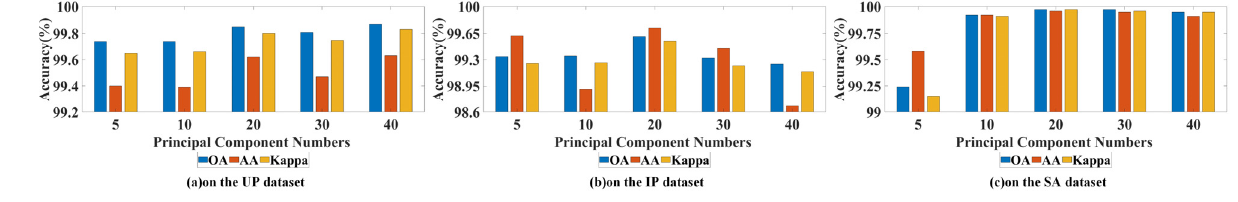
Figure 8. The effect of principal component numbers.